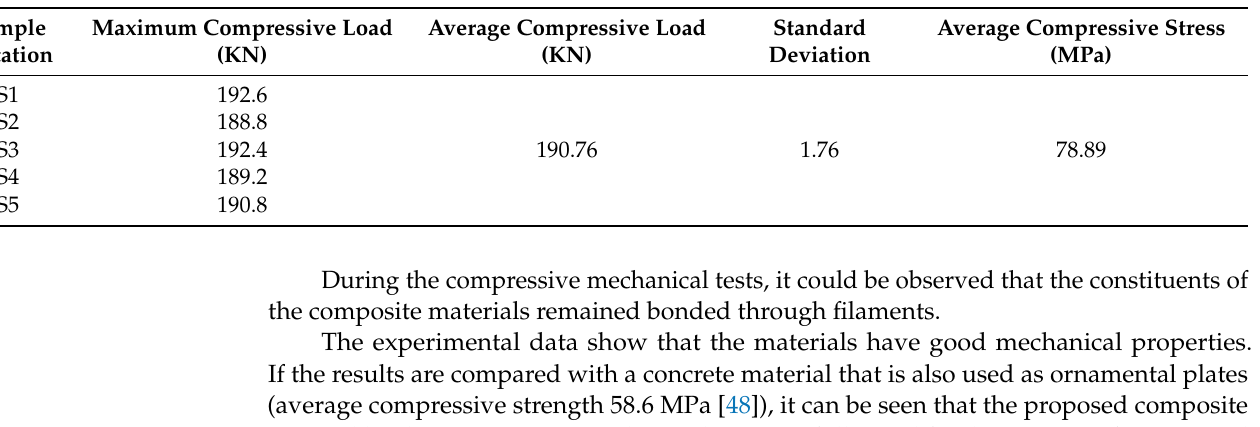
Table 1. Compressive tests results.